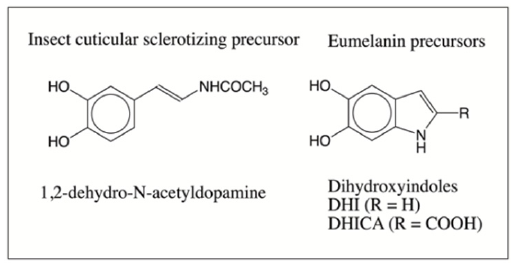
Figure 2. Structure of insect cuticular sclerotizing precursor 1,2-dehydro- N -acetyldopamine and eumelanin precursors DHI and DHICA.